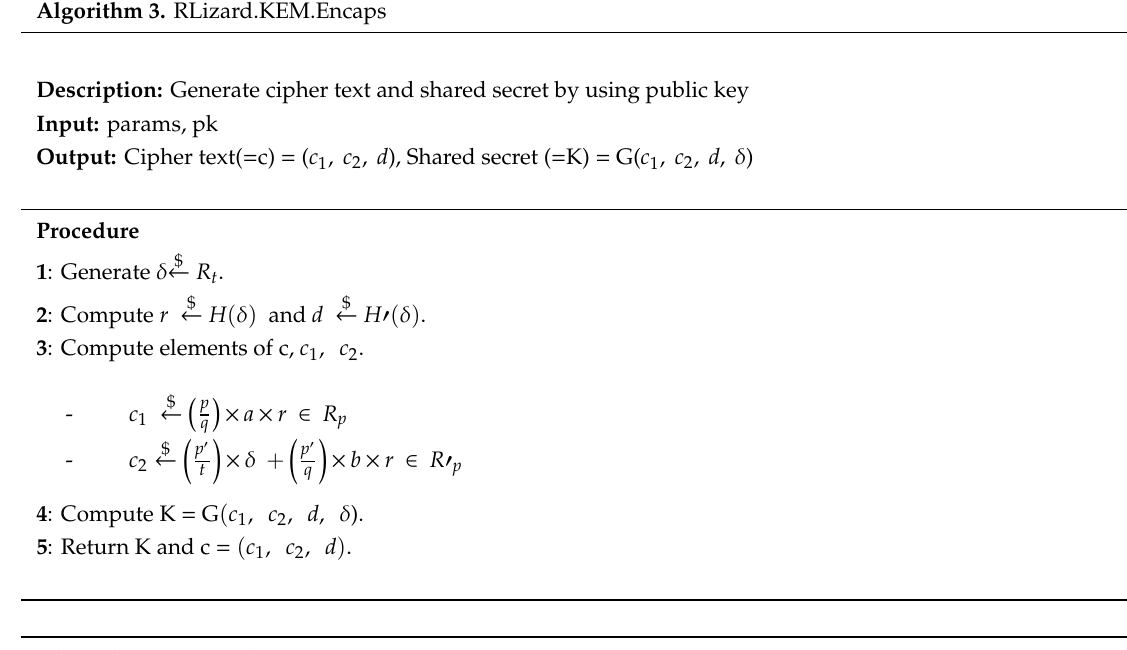
Algorithm 3. RLizard.KEM.Encaps